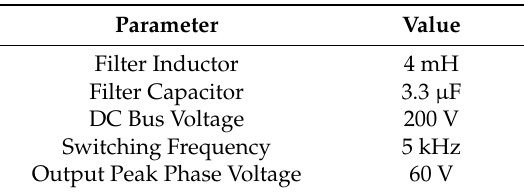
Table 1. System Table 1. System Parameters.